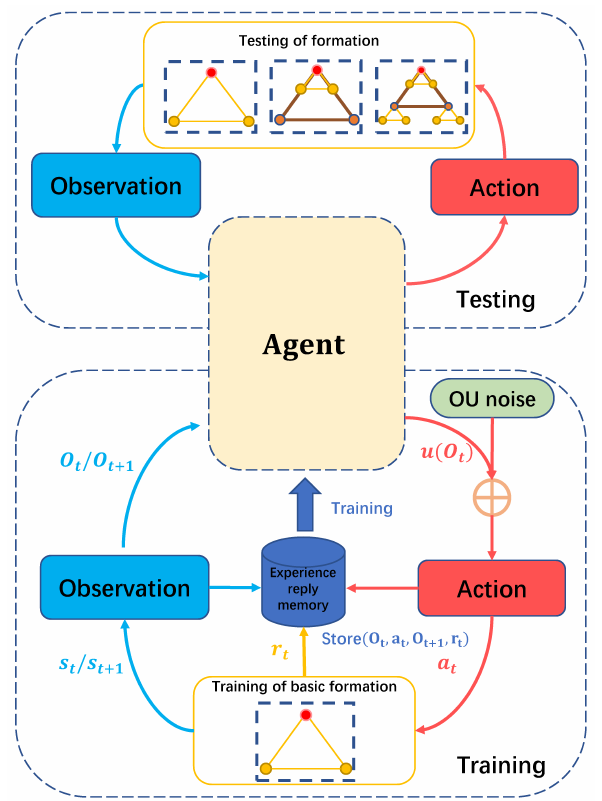
Figure 10. Illustration of the framework of agent training and